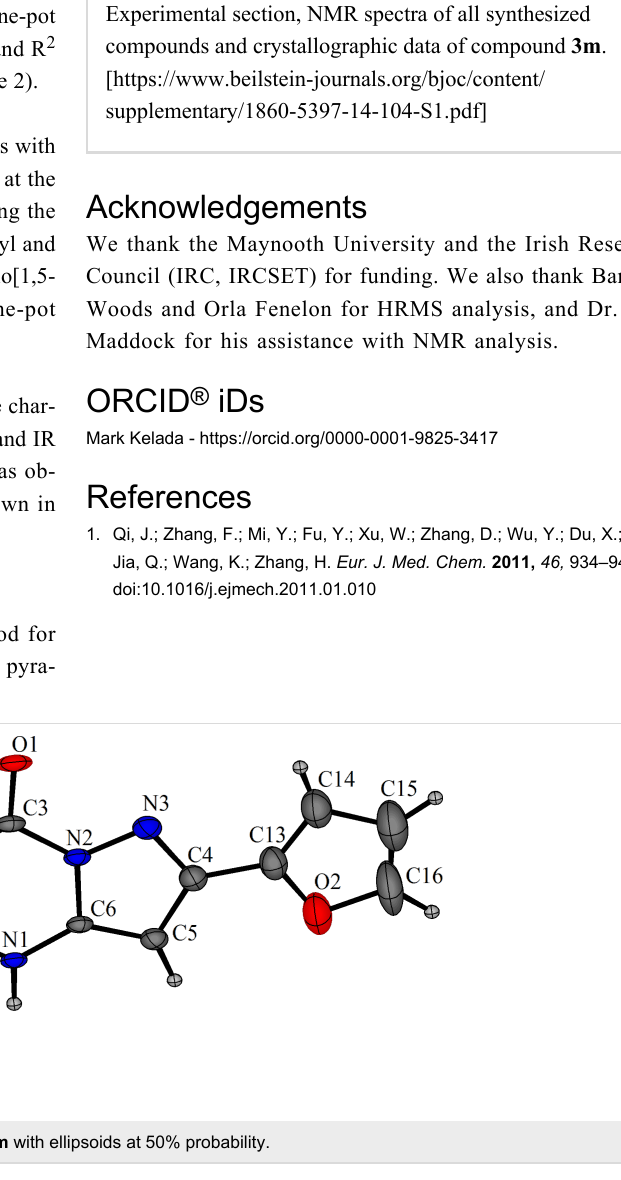
When a mixture of previously isolated 5-aminopyrazole 2a , β -ketoester, and acetic acid were heated under conventional refluxing conditions for 18 h, the product pyrazolo[1,5- a